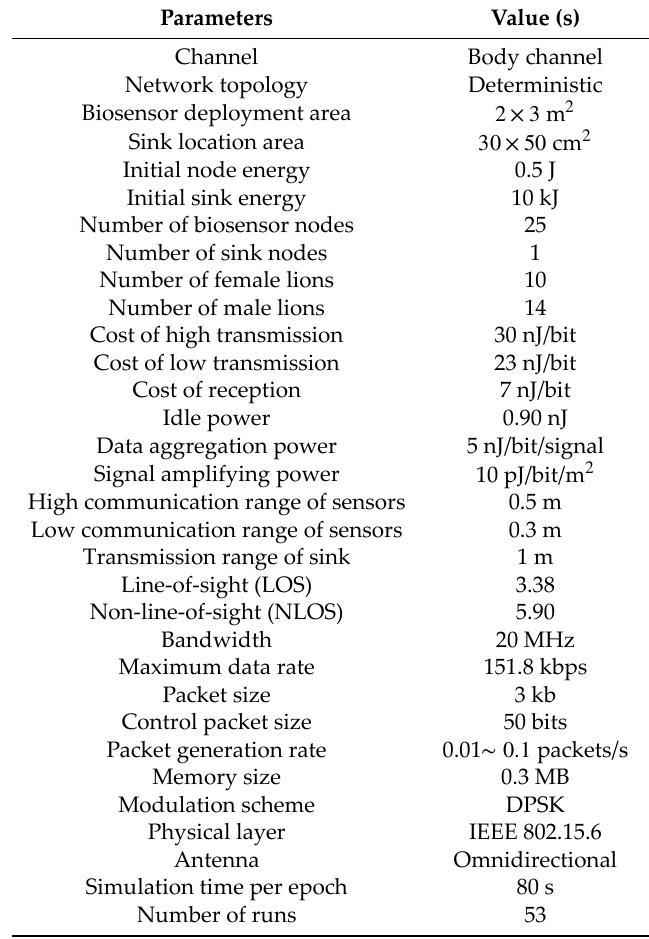
Table 3. Values of parameters used in